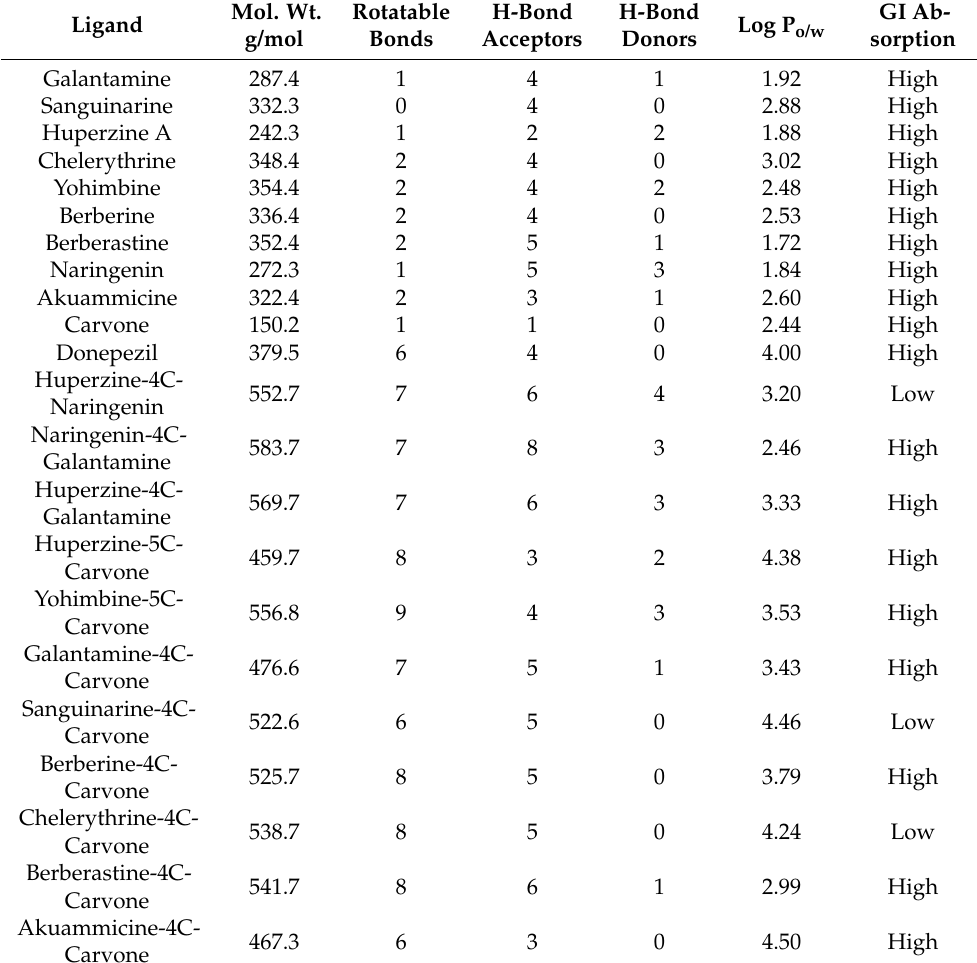
Table 3. Index of ADME properties to predict drug-likeliness of the screened